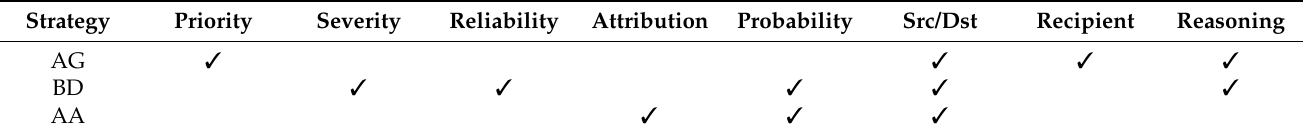
Table 3. Correlation matrix: inclusion of anomaly reports’ attributes per Reporting Strategy.